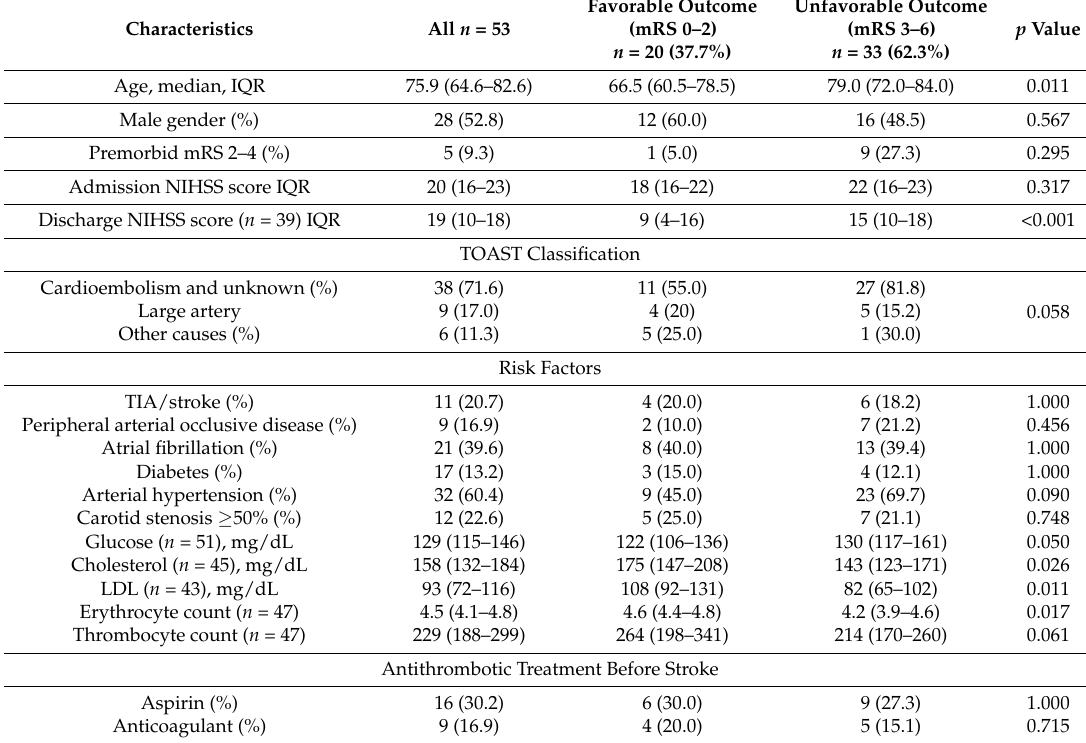
Abbreviations: EVT—endovascular treatment; NIHSS—National Institutes of Health Stroke scale; mRS—modified Rankin scale; TOAST—Trial of Org 10172 in Acute Stroke Treatment. Values in parentheses refers to interquartile range